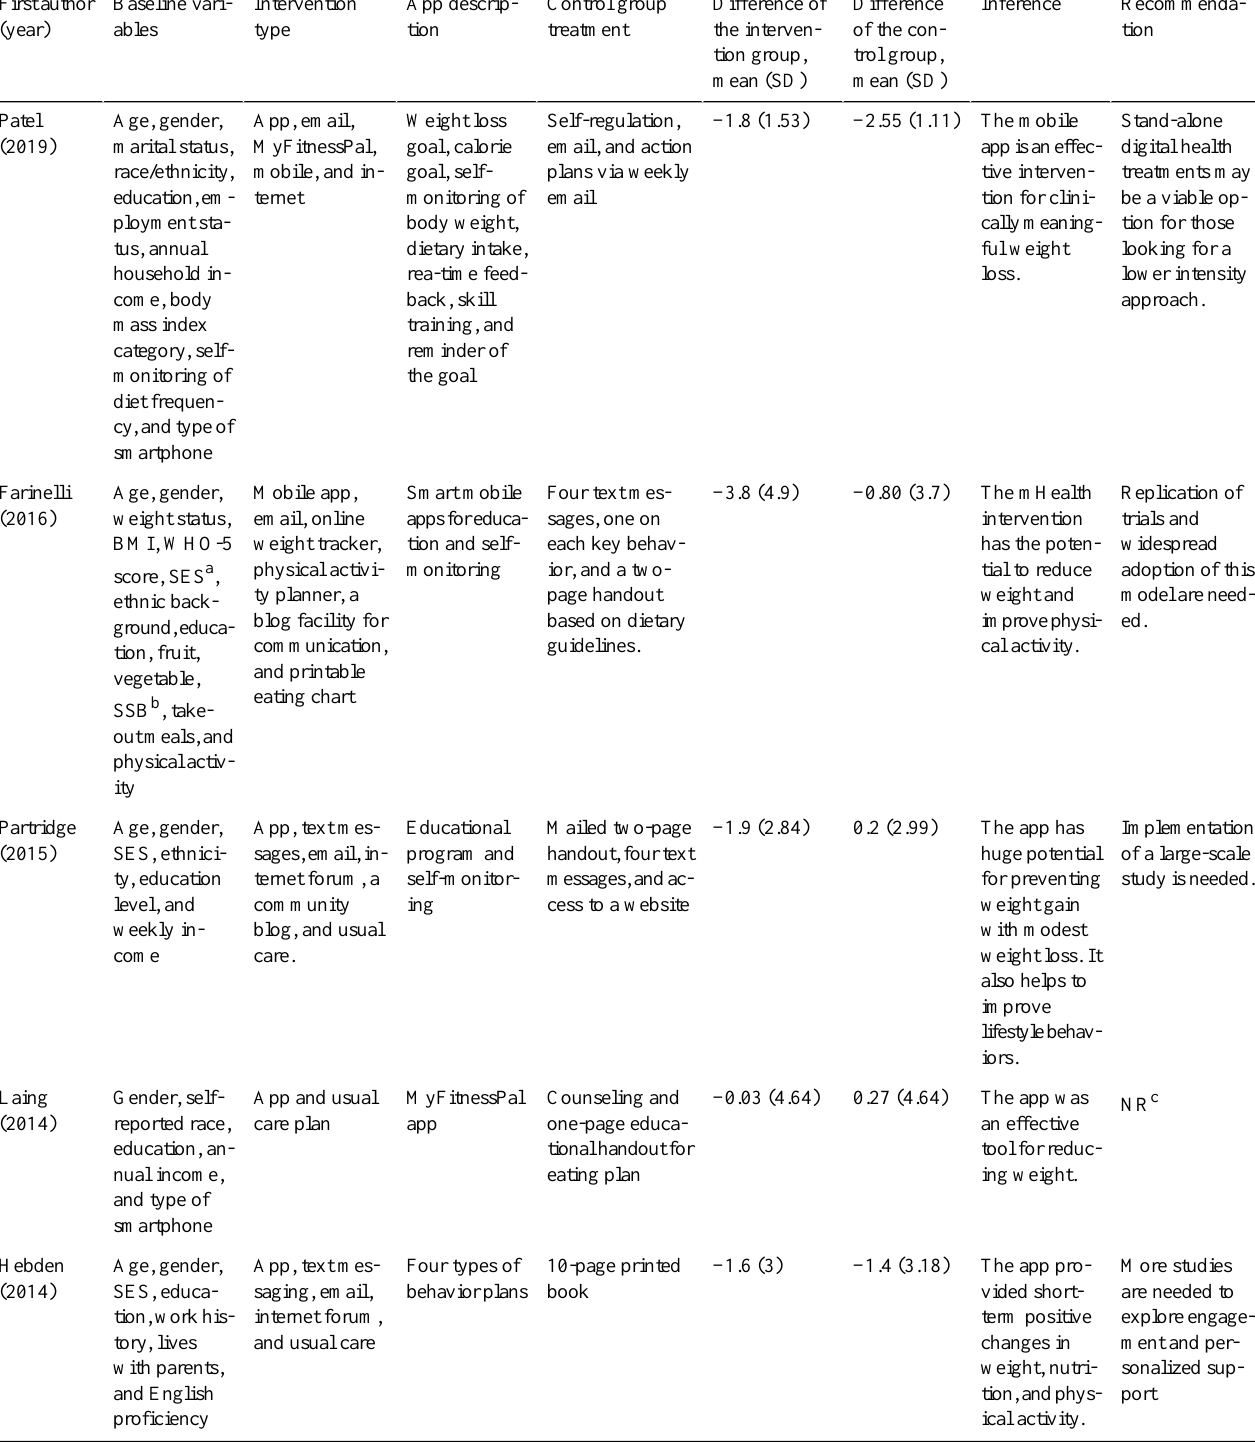
Table 2. Descriptions of baseline, interventions, apps, and findings of the included studies.